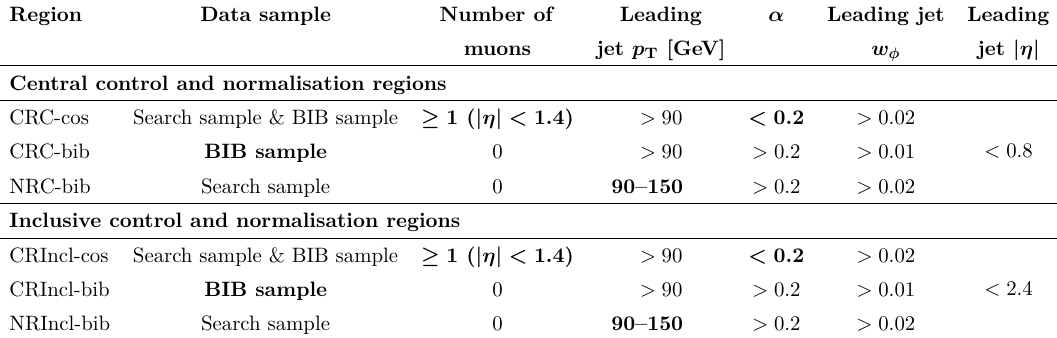
cosmic sample from potential R -hadron production in earlier pp collision data-taking was found to be